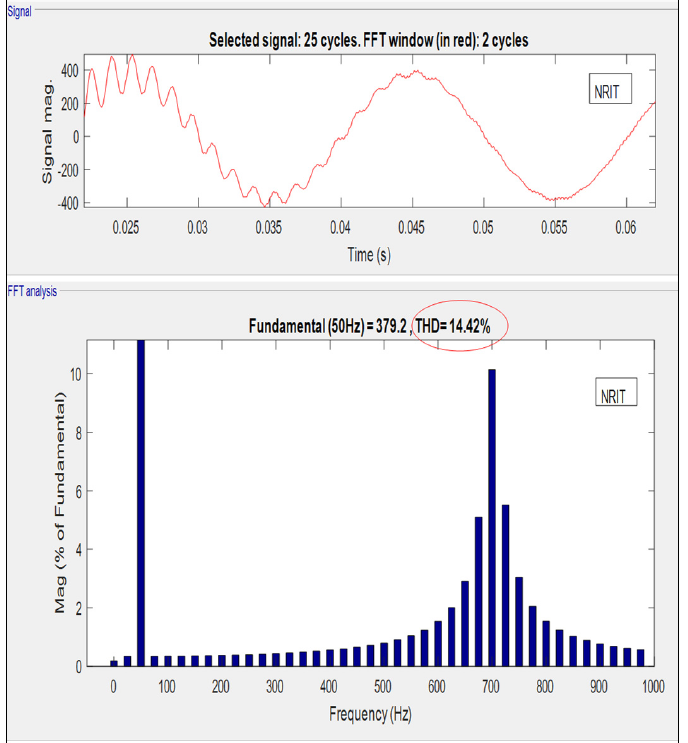
Figure 24. The THD case study 3 performance results with NRIT